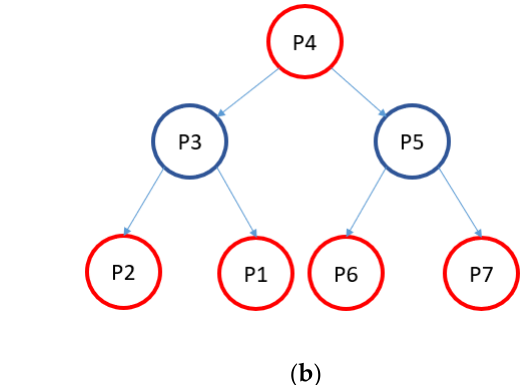
Figure 2. Illustration of kD-tree construction and nearest point search from the kD-tree: ( a ) two-dimensional dataset which has been split based on binary space partitioning; ( b ) representation of a kD-tree as a binary tree.